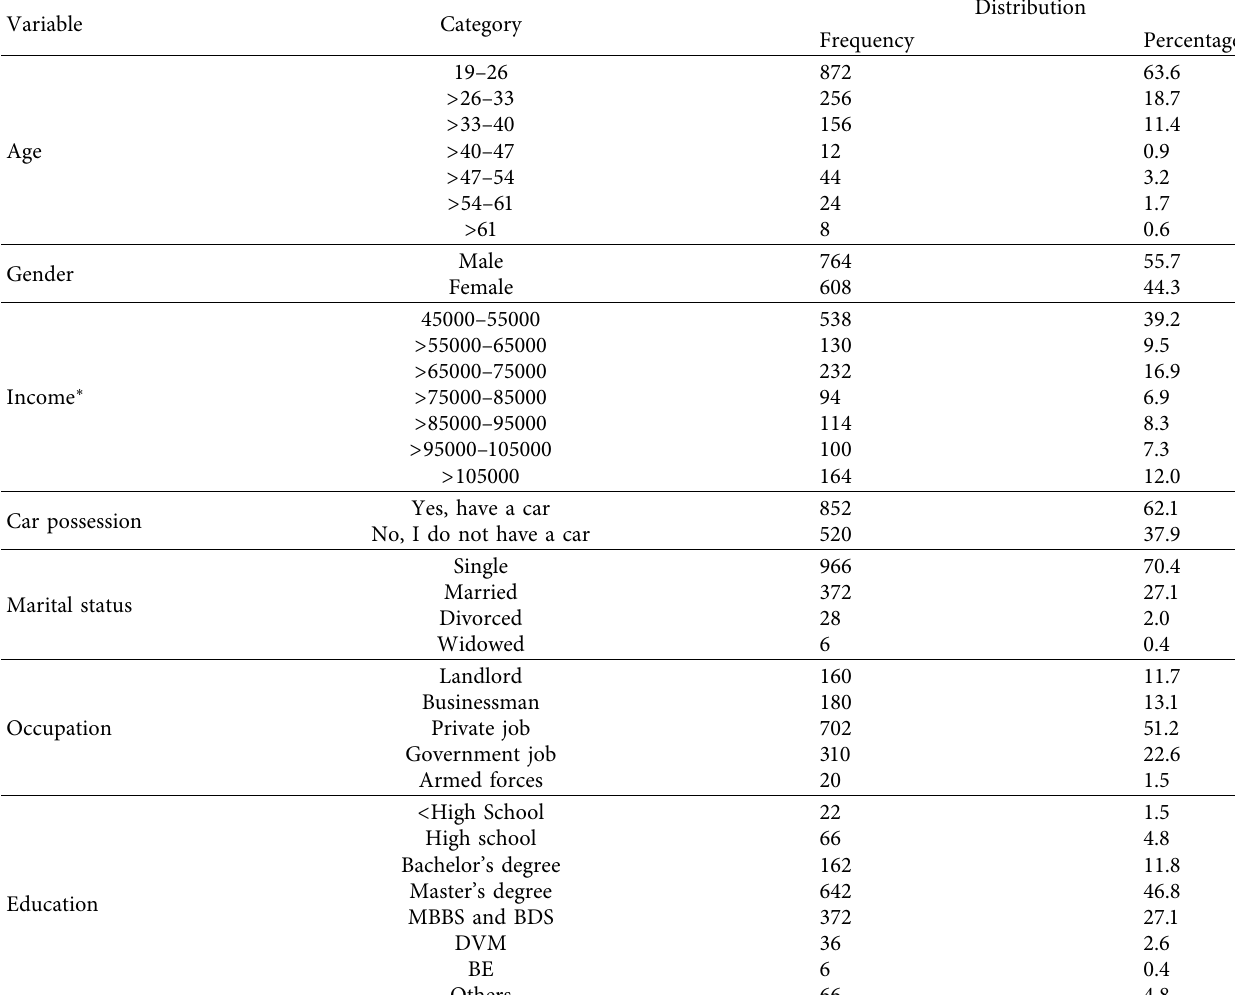
Table 2: Respondent’s